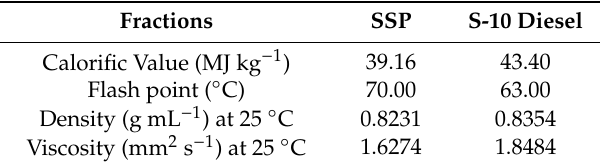
Table 4. Calorific value, flash point, density and viscosity SSP and S-10 Diesel.